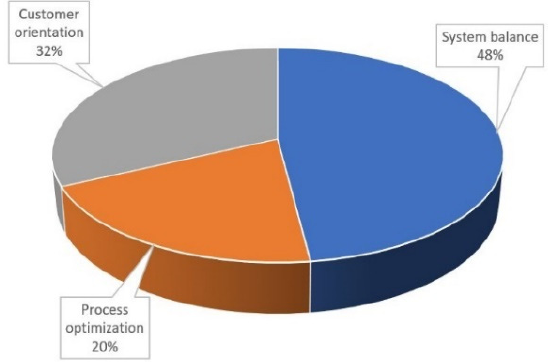
Figure 3. Analysis of digital applications in smart networks.